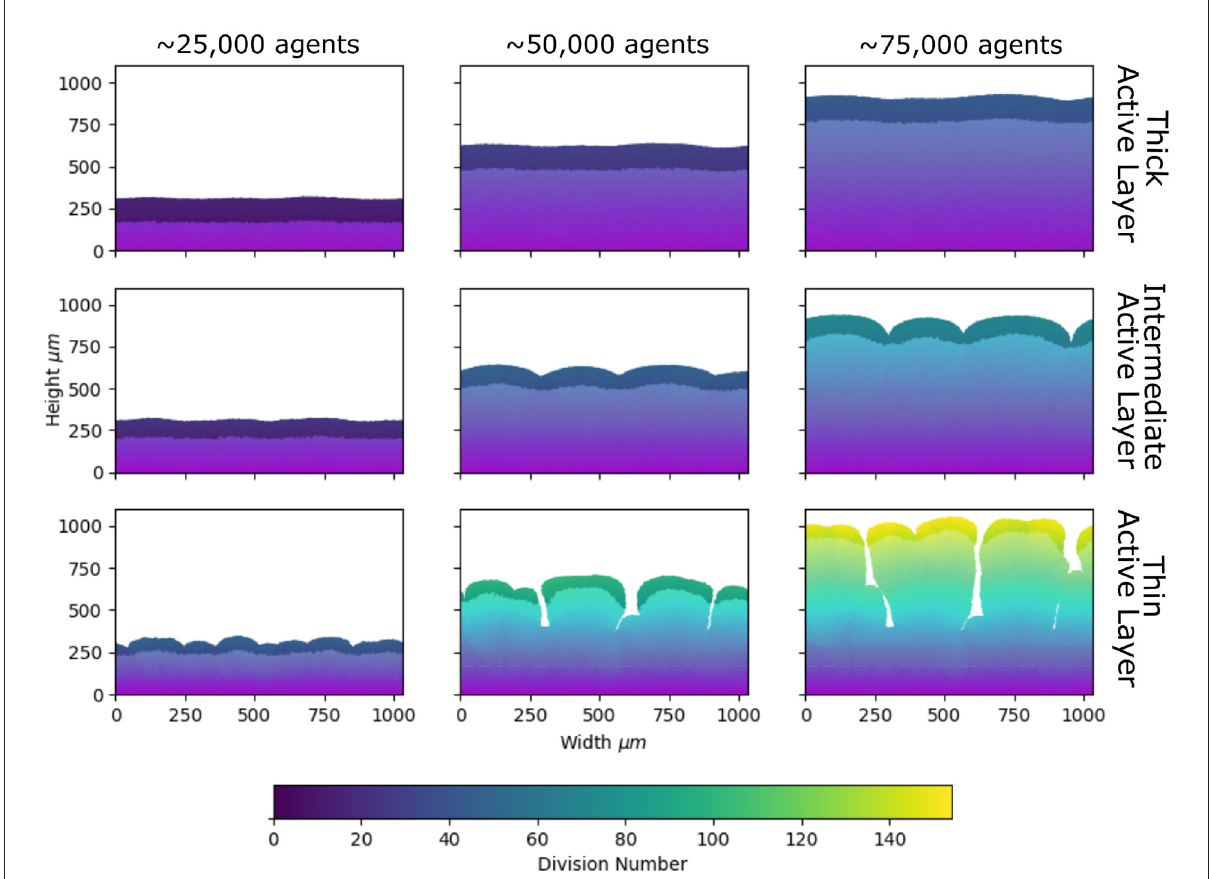
FIGURE4 Patterns of de novo diversity, inferred from lineage length. Snapshots from our simulations at different stages of biofilm growth, as in Figure 1, but color-coded according to lineage length (left to right: 25,000, 50,000, and 75,000 microbial agents; top to bottom: average active layer thicknesses 102.8 ± 0.8 , 71.3 ± 1.4 , and 40.8 ± 1.4 µ m ; parameters are given in the caption of Figure 1 and Table 1). Agents are colored according to their lineage length, i.e., the number of divisions that have occurred in the history of that agent since the start of the simulation (see Section Methods). The region of darker shading indicates the active layer (see section